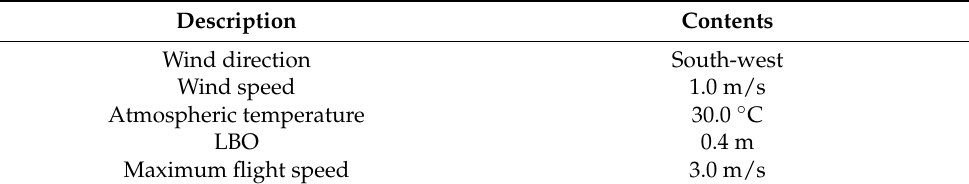
Table 2. Field experiment conditions and variables.